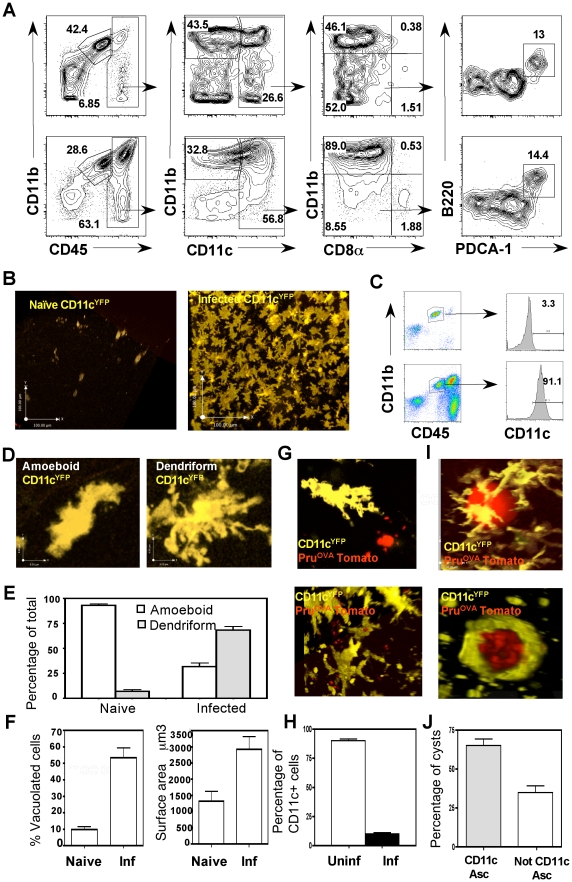
Phenotypic and behavioral characterization of CD11c+ cells within the brain.
A) The various APC populations found within CD3−CD19−NK1.1− fraction of BMNCs isolated from naive (top) or infected (bottom) mice. The first set of plots shows the relative proportions of microglia (CD45int CD11b+) and the other APCs of haematopoietic origin (CD45hi). The CD45hi population consists primarily of DCs (CD45hiCD11c+) and CD11b+ cells (macrophages/monocytes). The DC fraction was further subseted by staining for CD8, CD11b, PDCA and B220 to identify the myeloid (CD11b+CD11c+), lymphoid (CD11c+CD8+) and plasmacytoid (CD11c+CD11b−B220+PDCA+) DCs. B) 30 µm z stacks of brain slices from naive and infected CD11cYFP mice (D 21-post infection) imaged by 2-photon microscopy. C) The expression of CD11c on the microglia (CD45intCD11b+) from naive (top) or infected (bottom) mice. D) The two prominent types of morphologies (amoeboid and dendriform) observed amongst the CD11cYFP cells in the brain. E) The relative proportion of the amoeboid and dendriform cells (expressed as a percentage of the total CD11cYFP cells) analyzed from 30 µm z stacks of brain slices from naive and infected CD11cYFP mice. F) Left: Average number of vacuolated cells from multiple z stacks of brain slices from naive and infected CD11cYFP mice. Cells with greater than 2 vacuoles were included in the analysis. Right: The average surface area of CD11cYFP cells that was calculated from multiple z stacks (30 µm) of brain slices from naive and infected mice. G) CD11cYFP cells seen in association with a reactivating cyst (top) and tachyzoite infected CD11cYFP cells (bottom). H) The percentage of CD11c+ cells that were either uninfected (open bars) or infected (black bars) amongst BMNC isolated from PruOVA tomato infected mice. I) CD11cYFP cells in close association with parasite cysts (top panel). A cyst (showing individual bradyzoites) wrapped in YFP+ cells (bottom). J) The percentage of cysts observed across multiple imaging regions, that were either associated with or not associated with CD11cYFP cells.